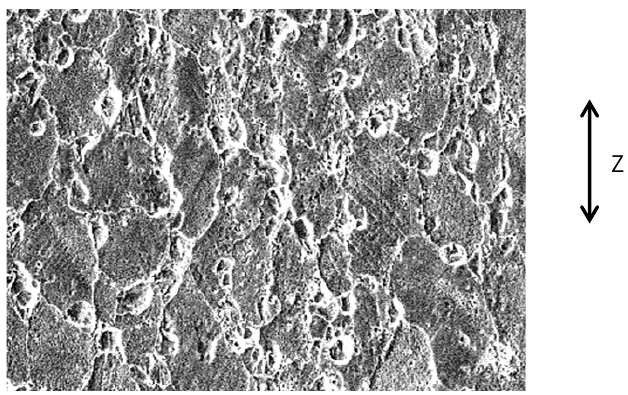
Figure 8. Intra-granular slip and elongated grain structure viewed on the axial plane.